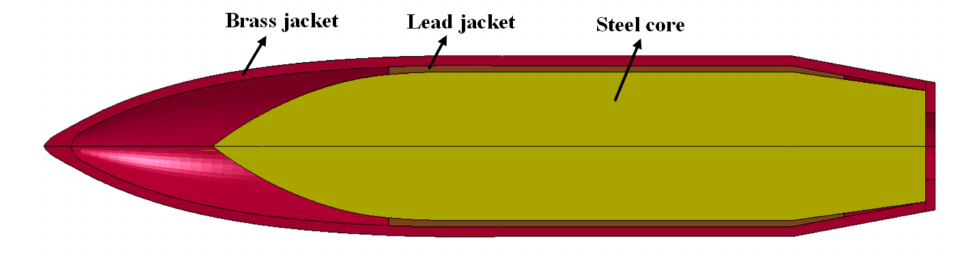
Figure 4. Structural details of the projectile.